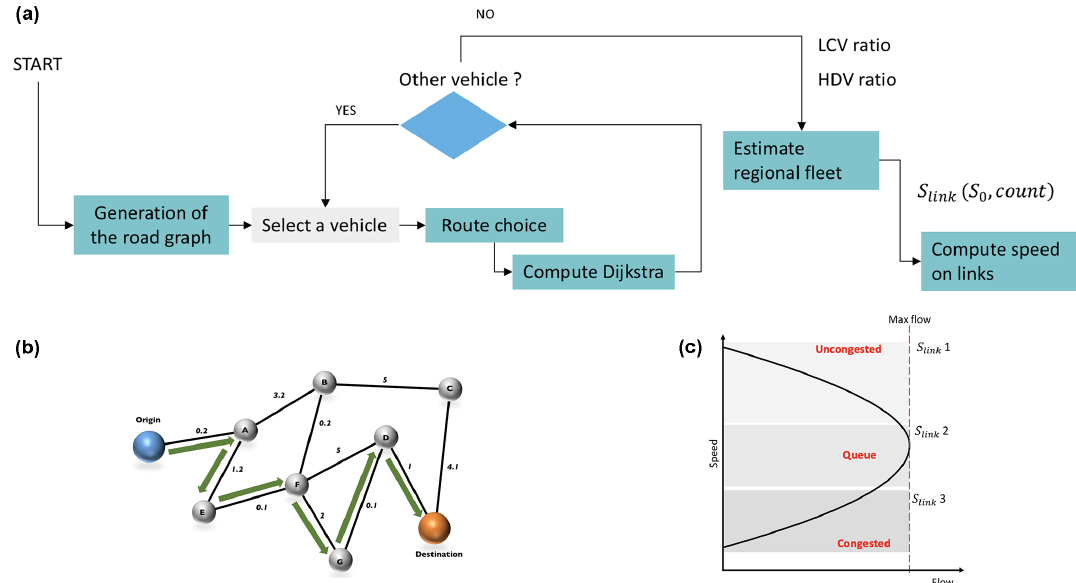
Figure 7. (a) Operating diagram of the assignment of transport demand on a road network (HERMES). (b) Representation of the calculation of the shortest path based on the speeds of road sections. (c) Speed flow curve of the MOIRAI module based on three levels of road